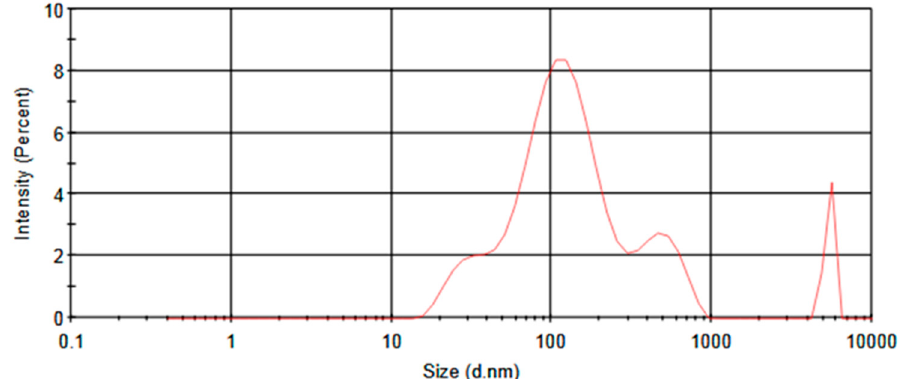
Figure 6. Particle size distribution of synthesized Ag NPs at obtained optimum synthesis conditions using J. regia leaf extract.